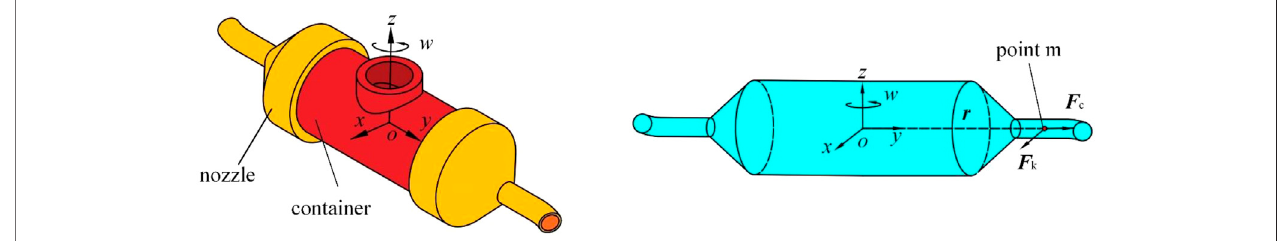
FIGURE3| Motionmodelofrotatingspinning. (A) Thestructureofcurved-tubenozzleandcontainer. (B) Thespinningsolutionincurved-tubenozzleandcontainer results with the experimental observations of power-law fl uid to validate the optimization model.